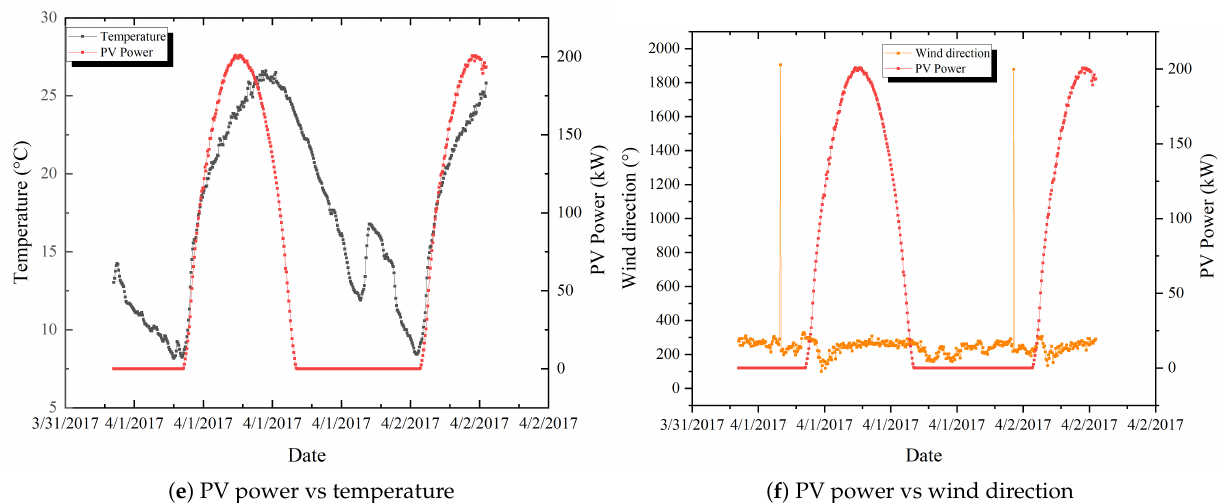
Figure 6. PV power time series with the related feature inputs: ( a ) diffuse horizontal radiation ( b ) horizontal radiation ( c ) relative humidity ( d ) previous PV power ( e ) temperature ( f ) wind